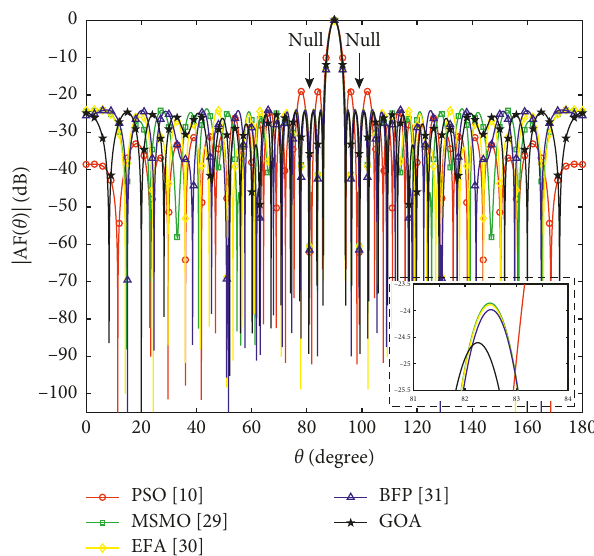
Figure 6: Array factor of 32-element linear array for example